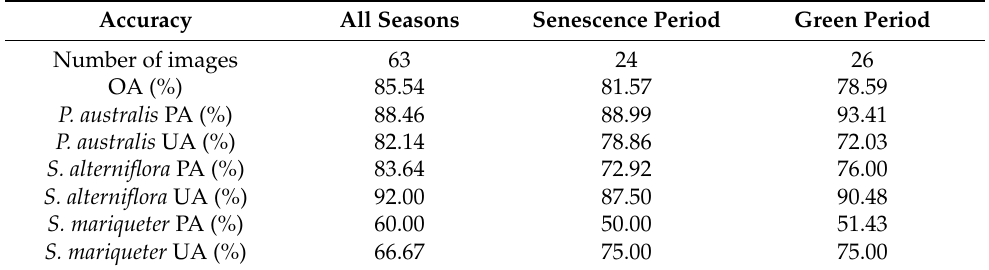
Table 5. Comparison of classifications among all seasons, the senescence period and the green period.